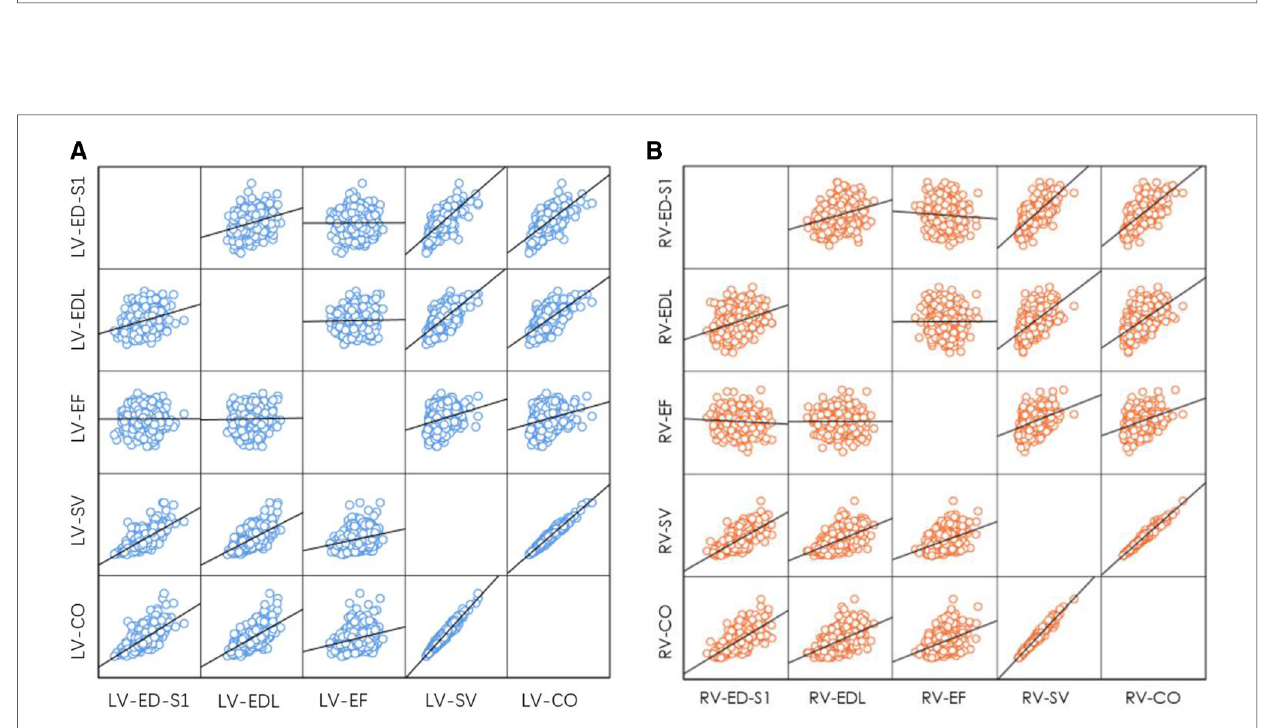
FIGURE 7 Scatterplots of left ventricular CO ( A ), right ventricular CO ( B ), and right-to-left ventricular CO ratio ( C ), according to gestational age (weeks), in 453 low- risk singleton pregnancies from 28 to 39 weeks gestation. Regression lines with the 5% and 95% con fi dence intervals are plotted with the regression equation. LV, left ventricle; RV, right ventricle; CO, cardiac output.